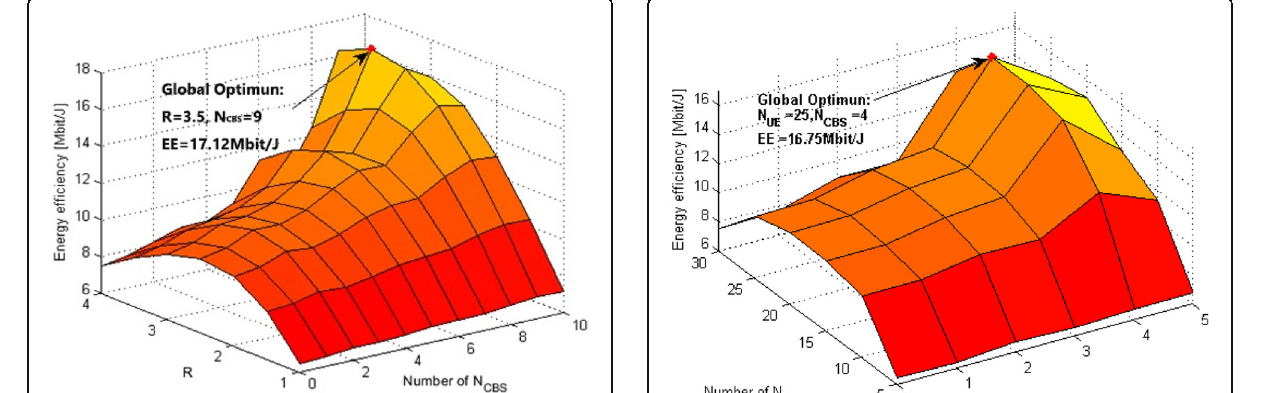
Fig. 4 EE with respect to different achievable rate constraints for N